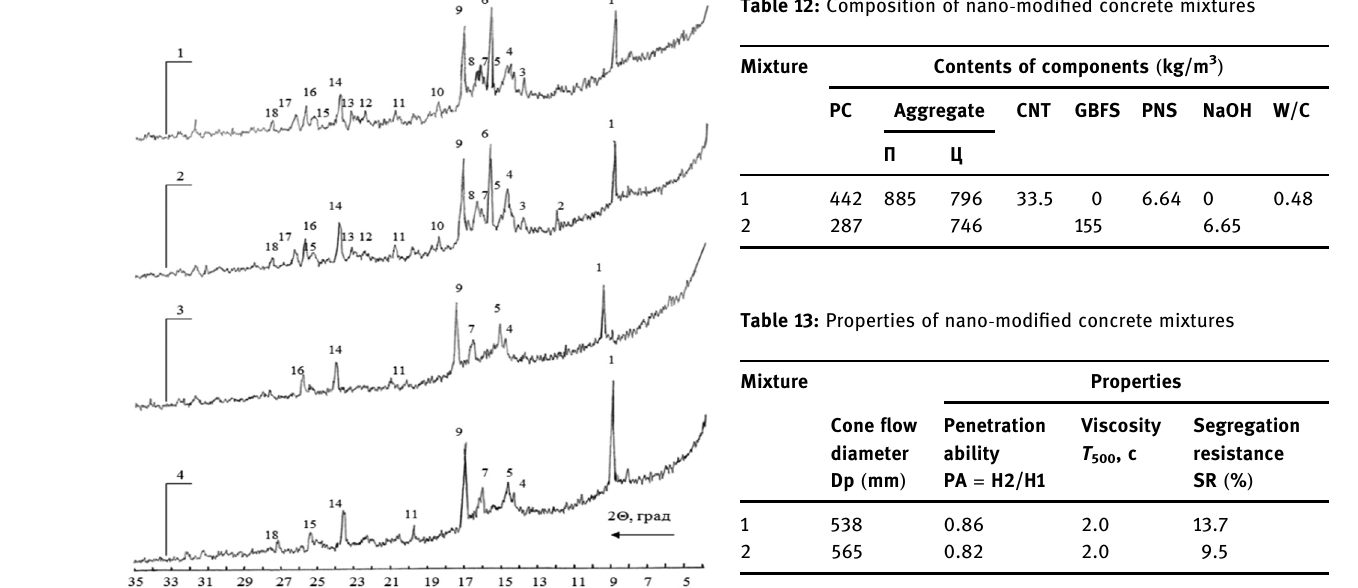
Figure 13: X - ray patterns of cement paste samples.